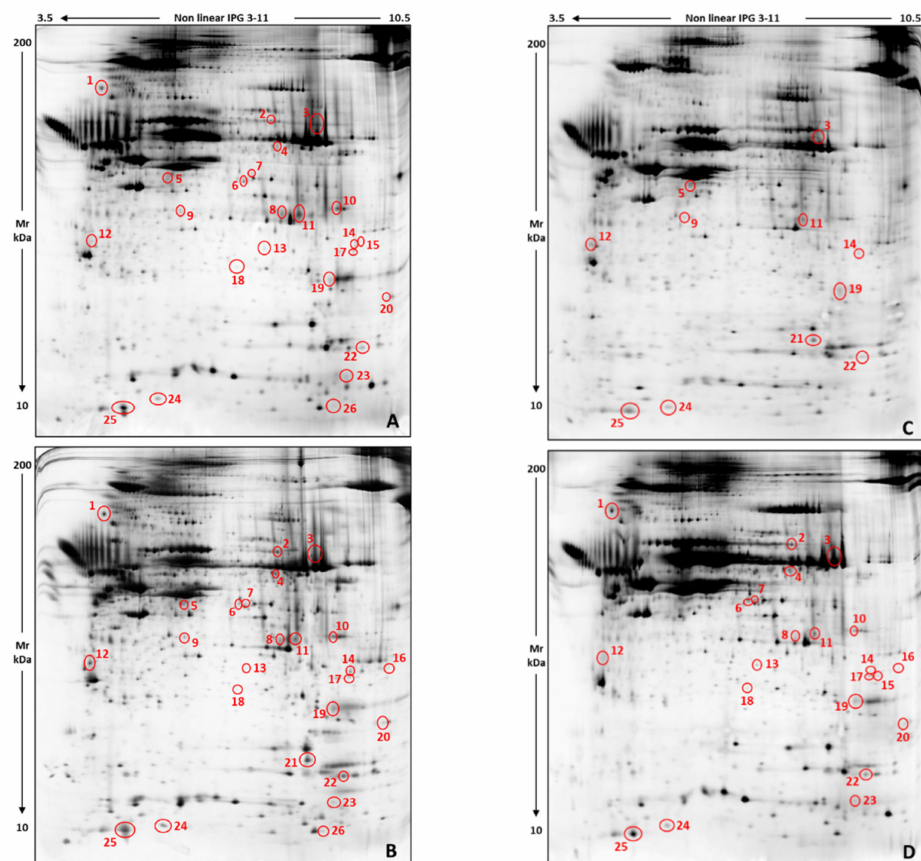
Figure 1. Representative 2-DE protein patterns of ex vivo skin-slice cultures from adult C. caretta turtles, treated with the DMSO vector (i.e. Ctrl) ( A ), MEHP + vector ( B ), chrysene + vector ( C ), and PBDE-47 + vector ( D ). Red circles and numbers evidence differentially abundant protein spots detected by comparing Ctrl vs. chrysene, MEHP, and PBDE-47; chrysene vs. MEHP and PBDE-47; and MEHP vs. PBDE-47. Numbers correspond to those listed in Table 1 and in